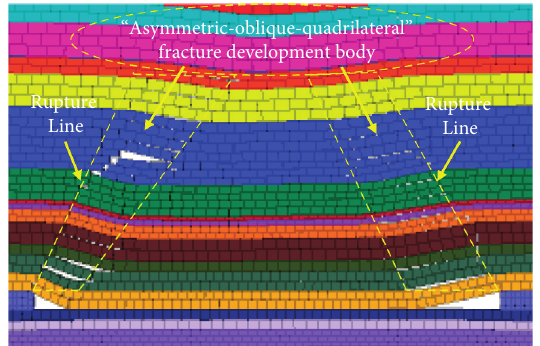
“Asymmetric-oblique-quadrilateral” fracture development body Rupture Line